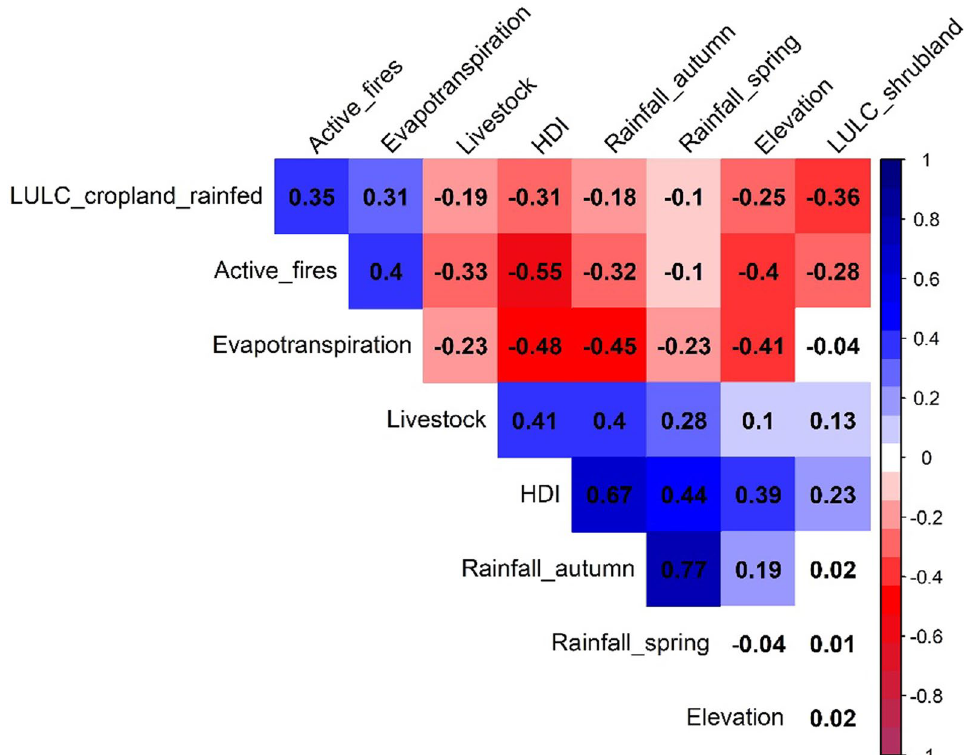
Fig. 2 The Pearson correlation analysis of the nine variables selected by PCA. The highlighted blue (red) square demonstrates a positive (negative) relationship between the variables analyzed. The result is statistically significant ( p < 0.05), ranging from – 1 to 1